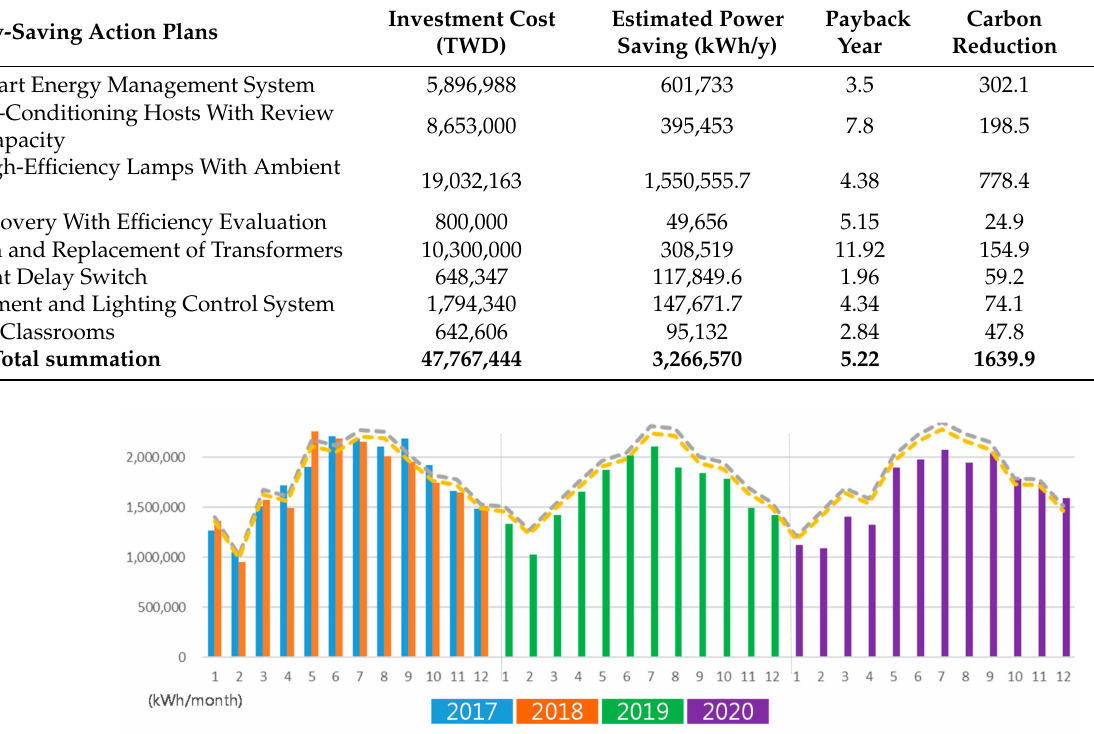
Table 1. Summary of energy-saving action plans and evaluation results.